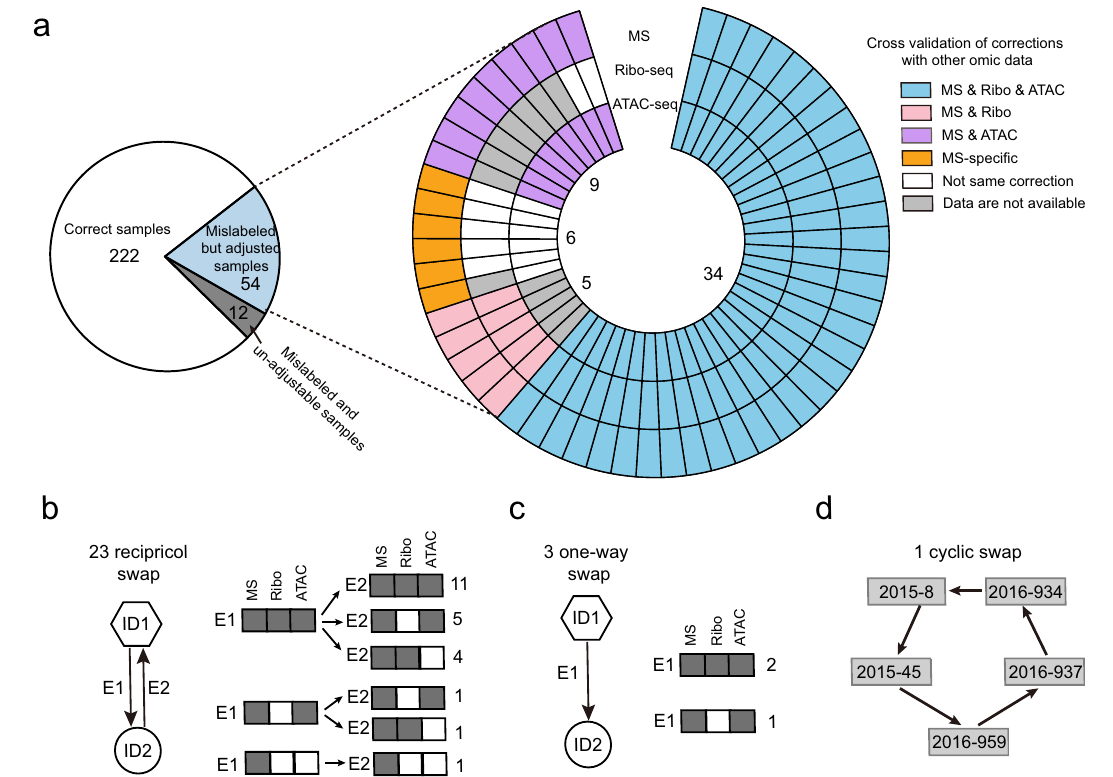
Fig. 4 Validation of sample calibration across other omic platforms. ( a ) The pie diagram shows the number of correct samples, mislabeled but adjustable samples, and mislabeled and un-adjustable samples. The circular plot shows the validation of sample corrections across different platforms. Each circle represents an omic platform. ( b – d ) Three types of sample calibrations and comparison of calibrations between different omic